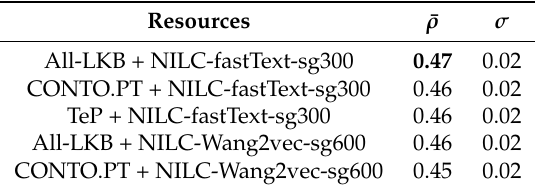
Table 19. Top Spearman correlation ( ρ ) for RareWords, based on the average of two different